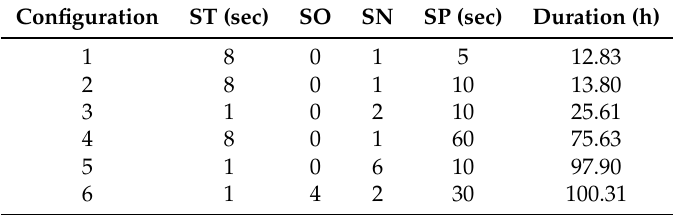
Table 2. Comparing different sleep mode parameters to study the battery life duration.